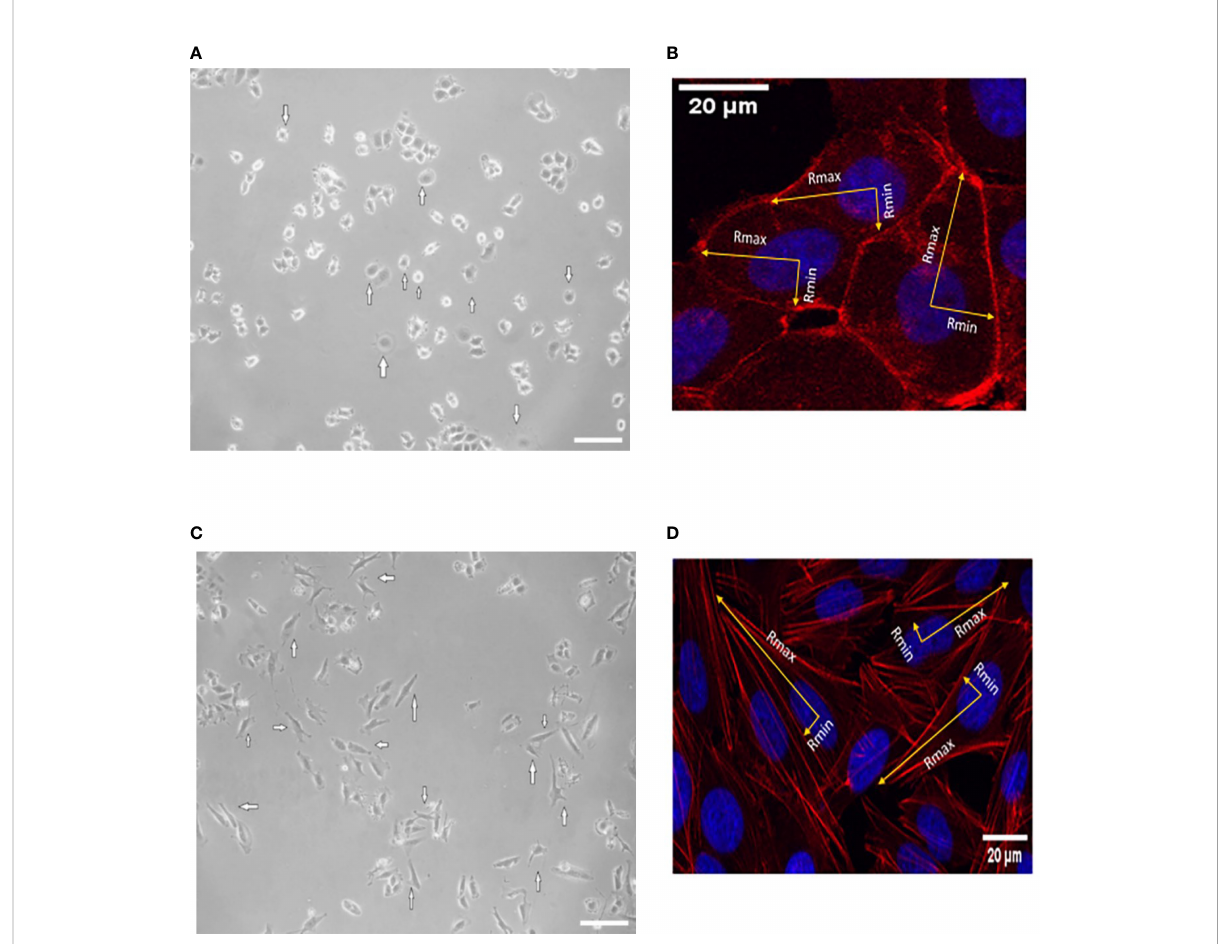
FIGURE 4 Represented images of spreading events of MCF-7 (A, B) and SKBR-3 (C, D) cancer cell lines after 20 h of incubation. White arrows indicate isotropic-like spreading in the case of MCF-7 cancer cells where the cell membrane extends and fl attens evenly in all directions and a similar distance from the center of the nucleus. Anisotropic spreading occurs in the case of SKBR-3 cancer cells where the cell membrane extends unevenly from the center of the nucleus to the protrusions ’ leading edge. The minimum and maximum cell radii are indicated with yellow arrows. The isotropic spread occurs when the aspect ratio of Rmax and Rmin is approximately 1. White color scale bar 40 m m, ×10 microscope lens (A, C) and 20 m m ×40 confocal lens ( B, D